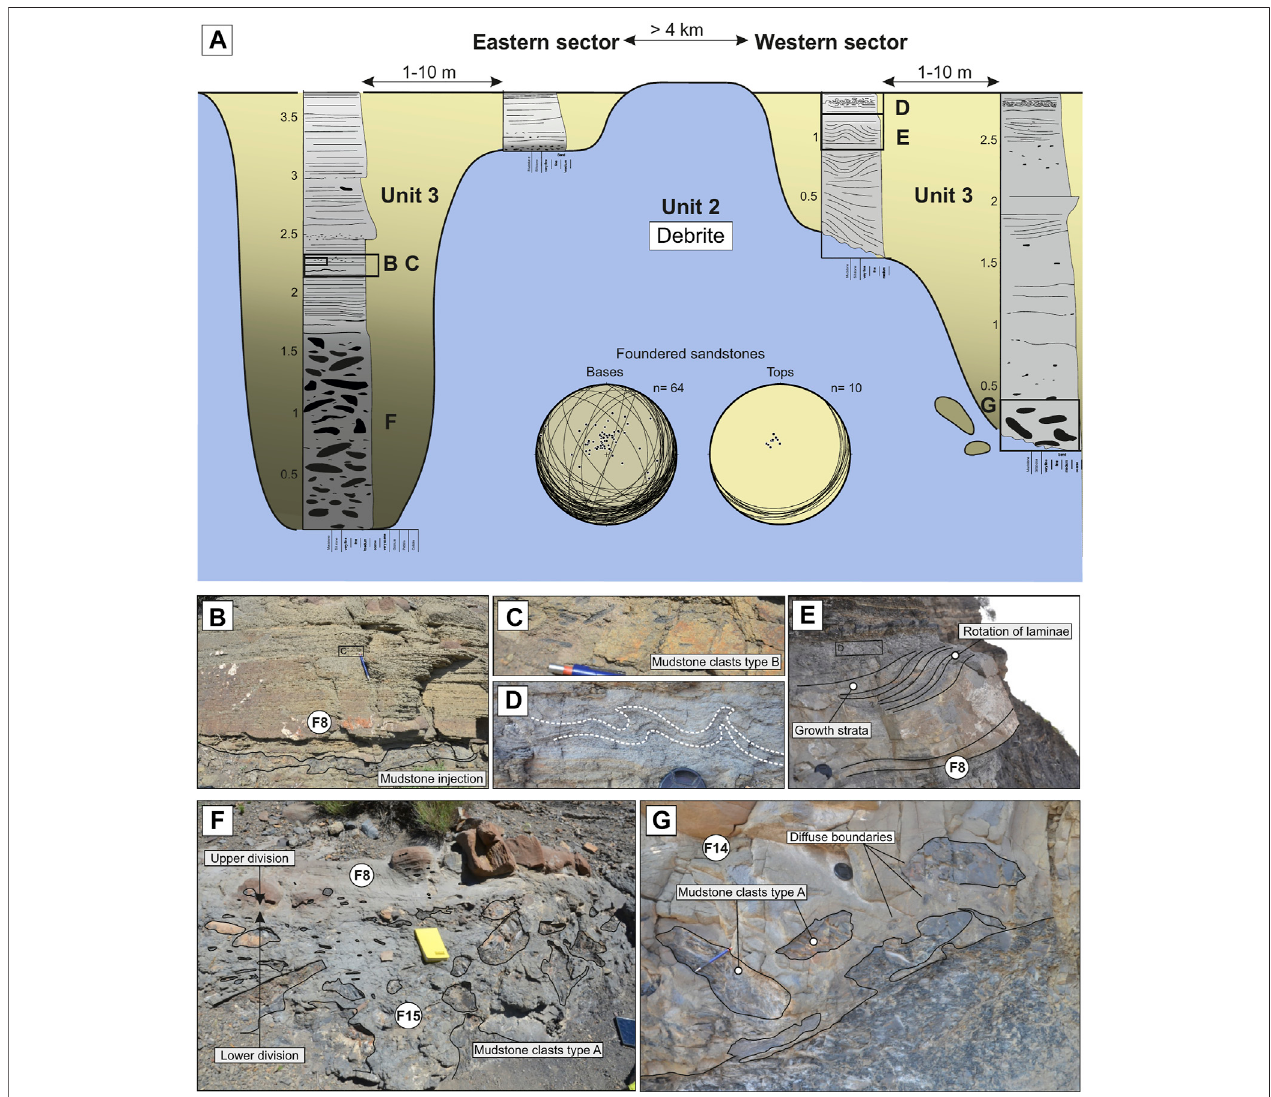
FIGURE6| Founderedsandstones(Unit3)diagram. (A) Illustrativecorrelationofsandstonefoundering(Unit3)intodebrite(Unit2).Notethedifferencebetweenthe conformable bed tops of matrix-poor and traction dominated sandstones (right-hand stereonet) and the mudstone clast- and matrix-rich sandstone texture near the unconformable bed bases (left-hand stereonet) , which shows the architecture of these sandstone bodies. (B) Thick-bedded banded sandstones with bedding- parallel sill injection (F8). See mudstone clasts (type B) in the inset (C) . (D) Convolute-laminae with NE vergence. (E) Sandstones showing rotation and growth strata. (F) Lowerdivision comprisingthick-beddedstructurelessargillaceous(F13)sandstone divisionwithapatchyandrandomdistributionofmudstoneclastsoverlain byupperdivisioncomprisingthick-beddedbandedsandstones(F8). (G) Thick-beddedstructurelesssandstonewithanundulatingirregularbasecomprisingdecimetre- scale mudstone clasts (type A)